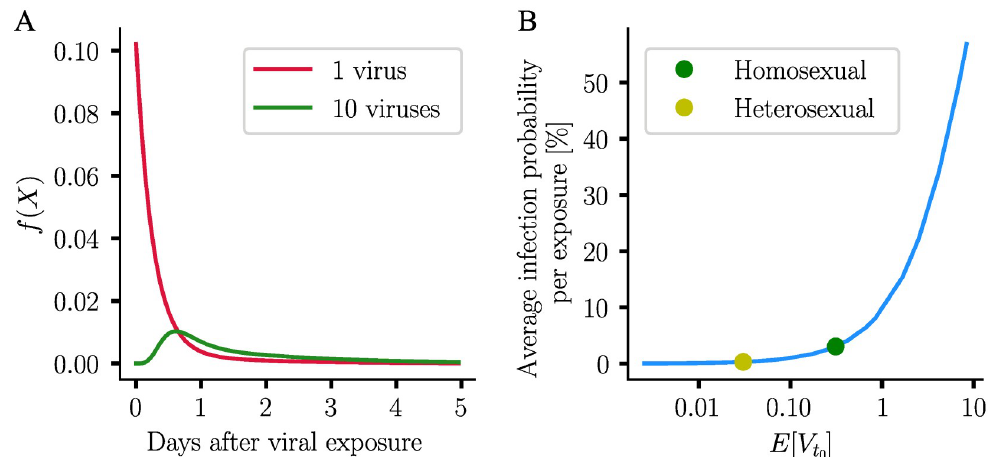
Fig 2. Model simulations in the absence of drugs. A . Probability density function of the extinction event in absence of drug, for one initial virus and 10 initial viruses respectively. B . Relation between the expected inoculum size and the corresponding average infection probability per exposure, in the absence of drugs. The distribution of inoculum sizes is described in [24]. Average infection probabilities for homosexual vs. heterosexual transmission [16], are marked by